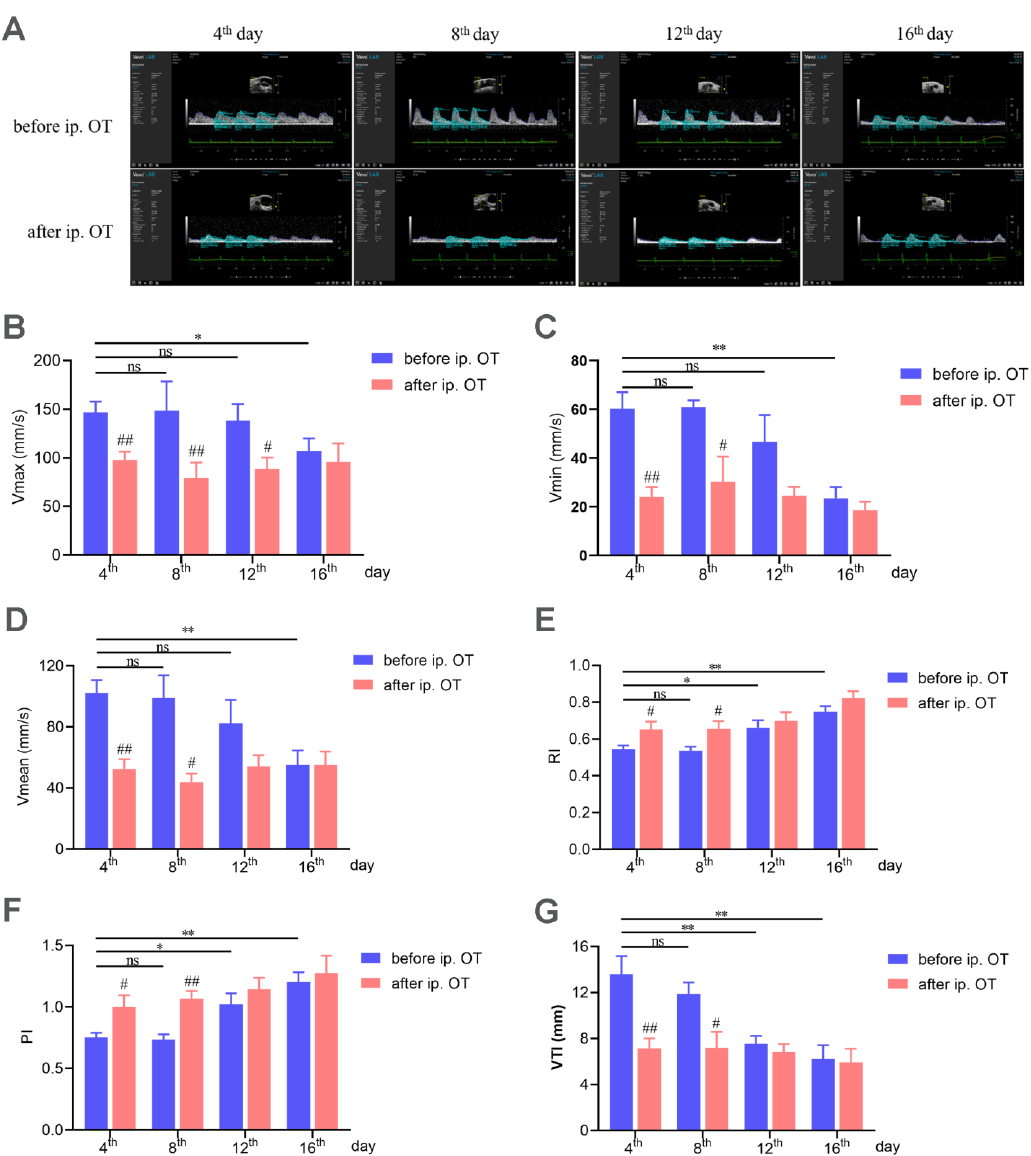
Figure 2. PD-related uterine artery blood flow features. ( A ) Typical images of uterine artery Doppler waveforms from model mice before and after oxytocin injection. ( B ) The maximum flow velocity (V max ) of the uterine artery. ( C ) The minimum flow velocity (V min ) of the uterine artery. ( D ) The average flow velocity (V mean ) of the uterine artery. ( E ) Resistive index (RI) of uterine artery blood flow. ( F ) Pulsatility index (PI) of the uterine artery. ( G ) Velocity time integral (VTI) of uterine artery blood flow. # Model group after oxytocin injection compared with the corresponding model group before oxytocin injection. # p < 0.05; ## p < 0.01. * p < 0.05; ** p < 0.01. ns, no significance. (n = 6 per group).